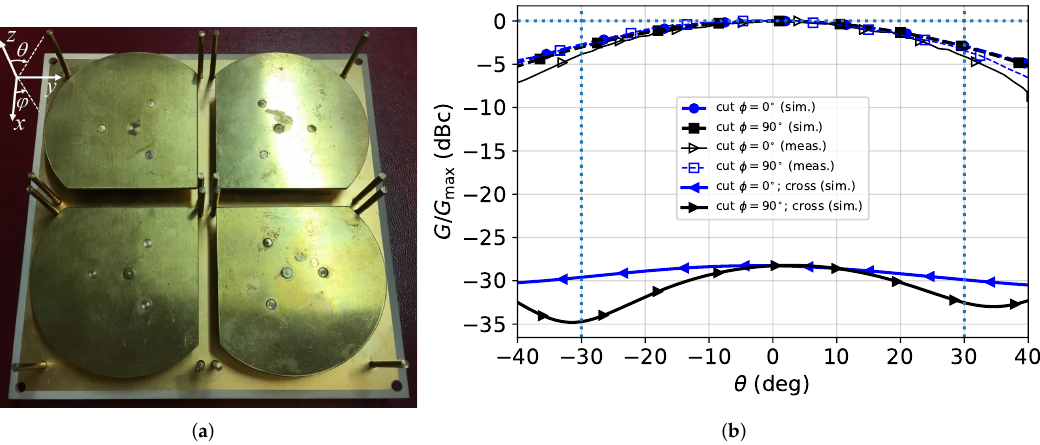
Figure 6. ( a ) Prototype of dual-CP sequentially-fed 2-by-2 antenna array. ( b ) Simulated co-polar (thin continuous black line with empty triangles for the cut plane at φ = 0 ◦ , thin blue dashed line with empty squares for the cut plane at φ = 90 ◦ ) and measured co-polar (thin continuous black line with empty triangles for the cut plane at φ = 0 ◦ , thin blue dashed line with empty squares for the cut plane at φ = 90 ◦ ) and simulated cross-polar (thick blue and black continuous lines with filled triangles for the cut planes at φ = 0 ◦ and φ = 90 ◦ , respectively) gains of the array antenna at the central frequency f = 2.2 GHz.